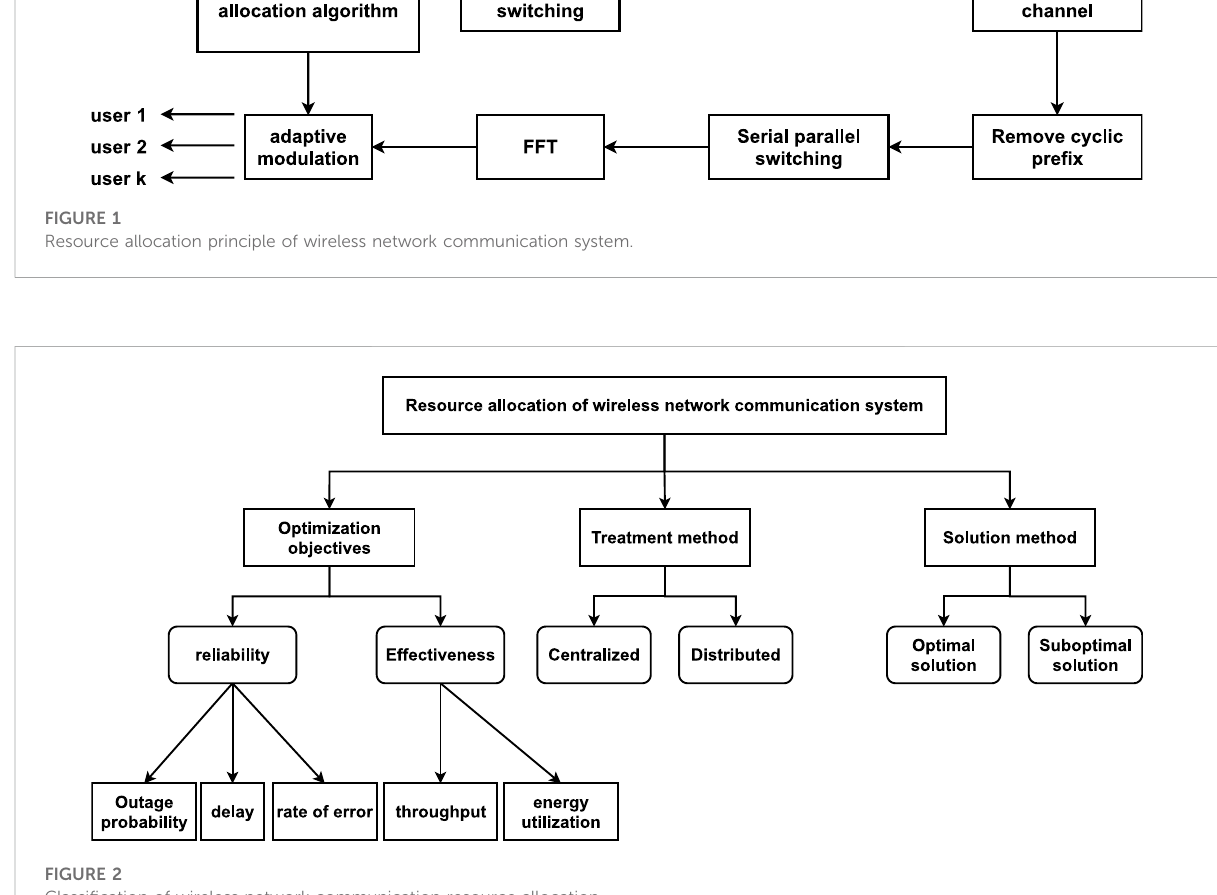
FIGURE 2 Classi fi cation of wireless network communication resource